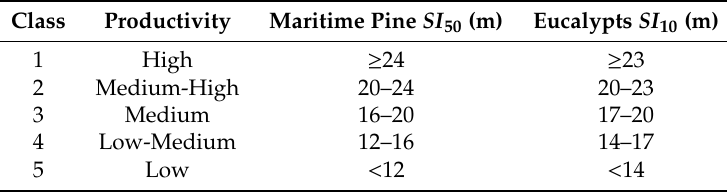
Table 5. Reference productivity classes